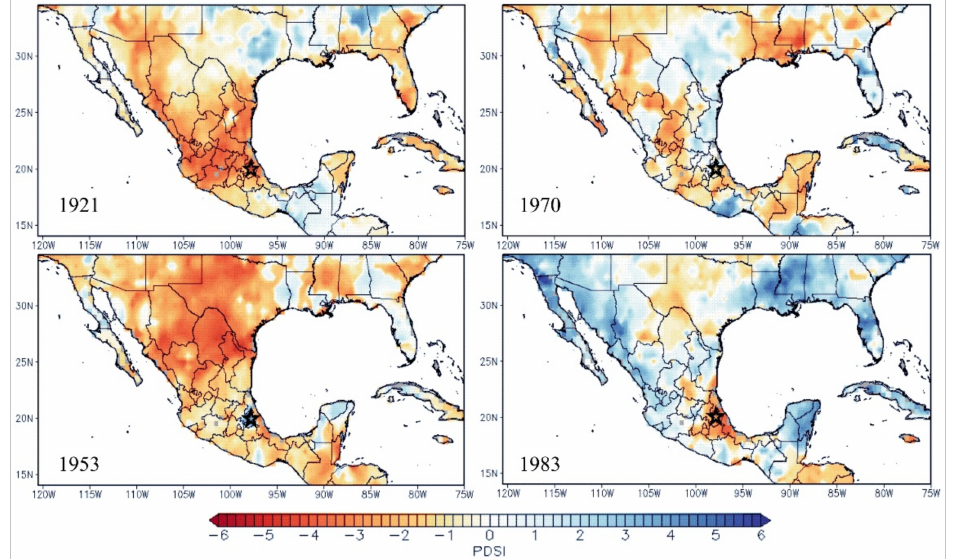
Figure 6. Geographic extent and severity of drought conditions in Mexico [46] during four widespread fire years. The black star symbol indicates the location of the study